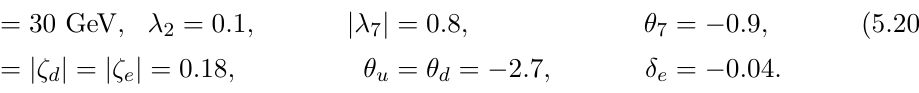
Figure 5 . The correlation between | d e | / | d exp in figure 4. The vertically parallel pink region explains the observed BAU shown in eq. (1.1) within 95%